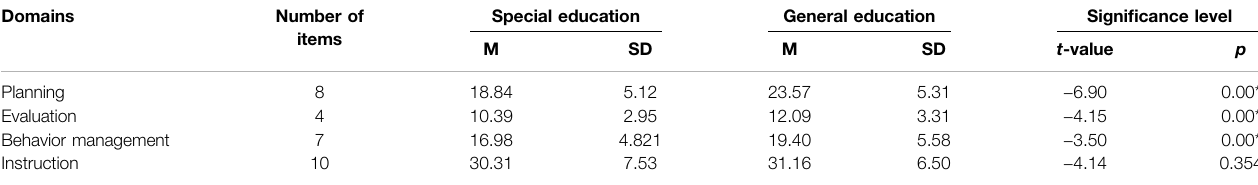
TABLE 2 | T -test comparison of special education and general education teachers on the four domains of the instrument. Domains